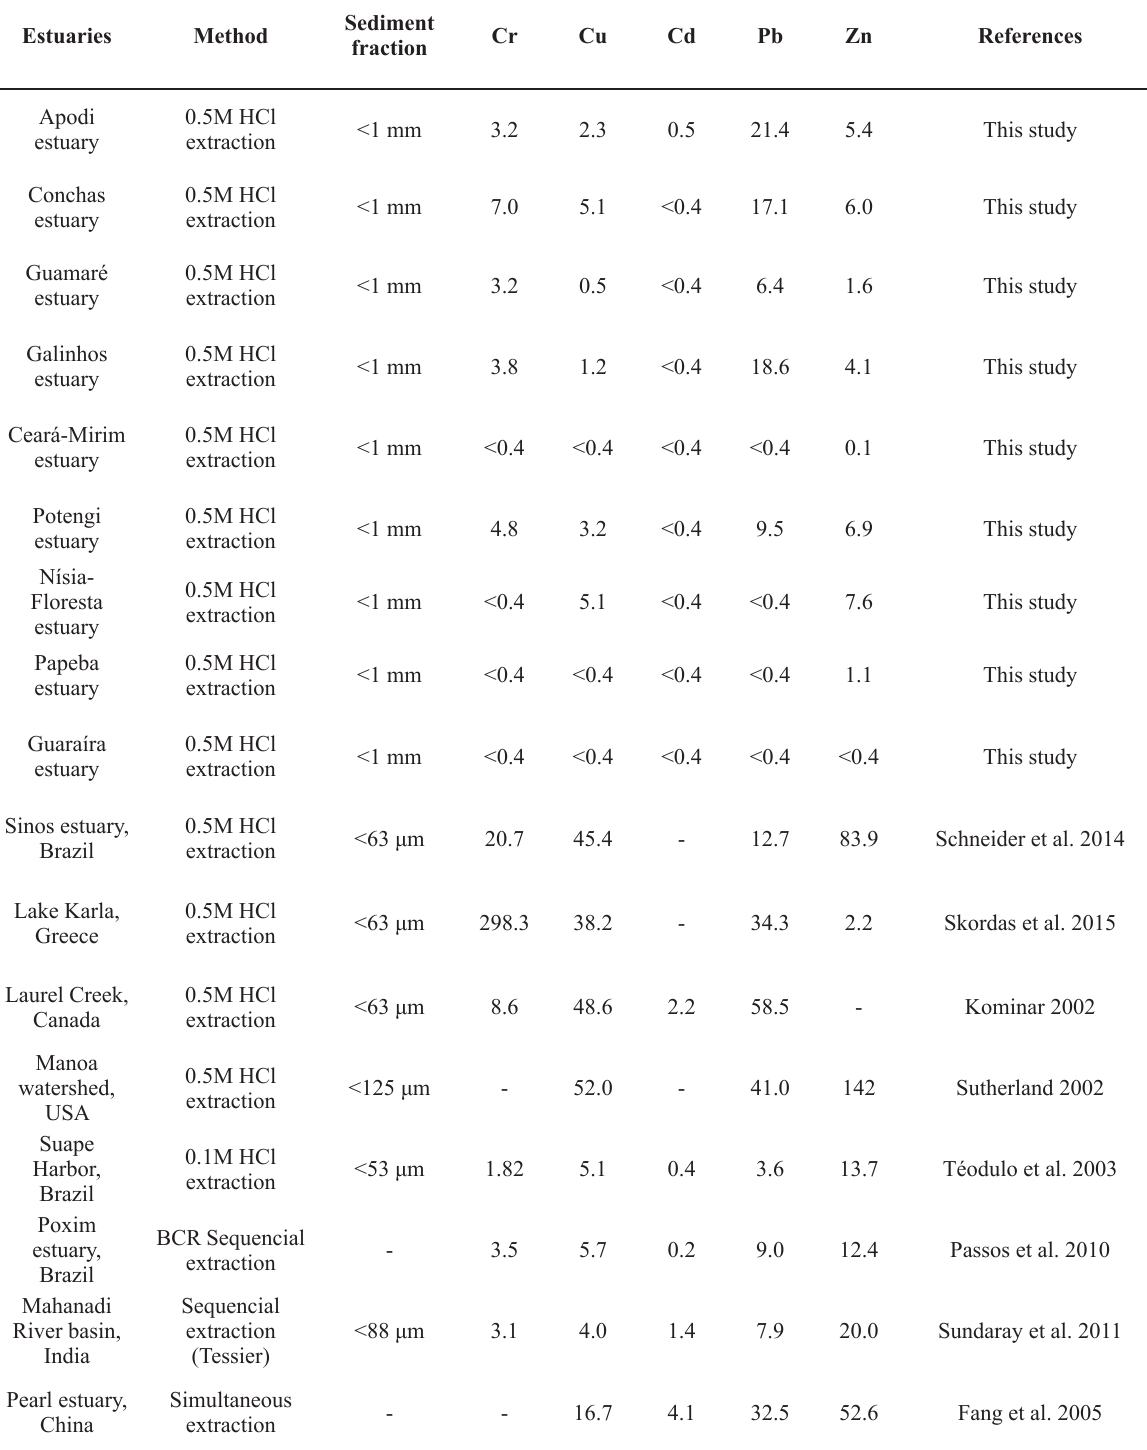
Metal concentrations in the estuaries of Rio Grande do Norte and reference data in sediments of different systems around the world (average values in m